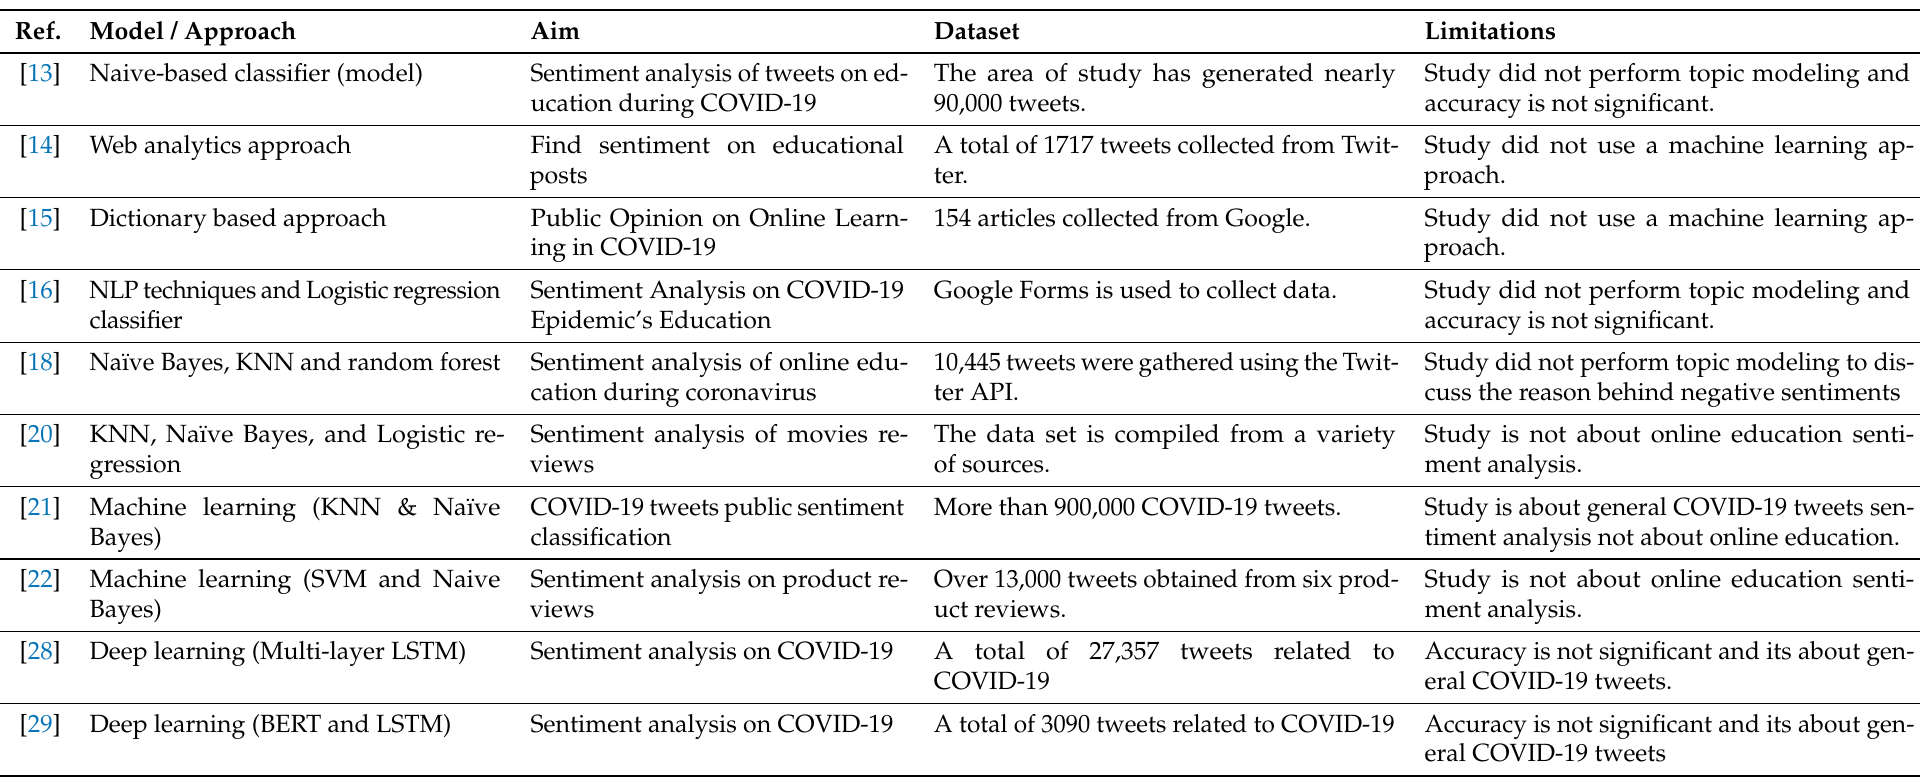
Table 1. A summary of related